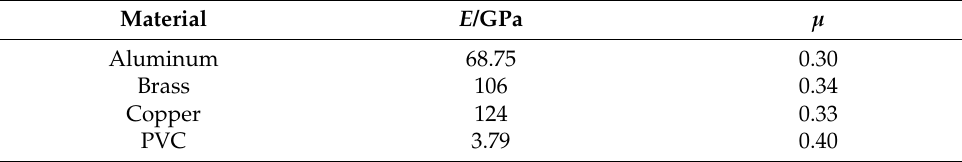
Table 6. Material parameters of scaled